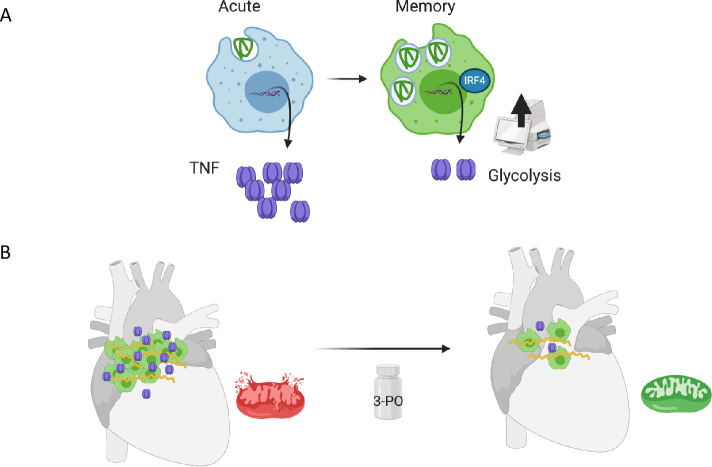
Cartoon model of the generation of innate memory responses to B. burgdorferi in vitro and in vivo.(A) Memory macrophages show increased binding of the spirochete, their internalization, and decreased production of TNF compared to acutely stimulated cells. Memory cells also show increased expression of Irf4 and augmented glycolysis. (B) Cardiac infection with B. burgdorferi results in the infiltration of macrophages with increased expression of Irf4 and the down-regulation of mitochondrial proteins and gene expression. The inhibition of glycolysis during infection with the PFKFB3 inhibitor, 3-PO, results in decreased bacterial burdens, reduced macrophage infiltration, and lower expression of Tnf. The transcriptomic analysis of 3-PO-treated, infected hearts show increased expression of mitochondrial genes. The art work was created with BioRender.com. 3-PO, 3-(3-pyridinyl)-1-(4-pyridinyl)-2-propen-1-one; TNF, tumor necrosis factor.